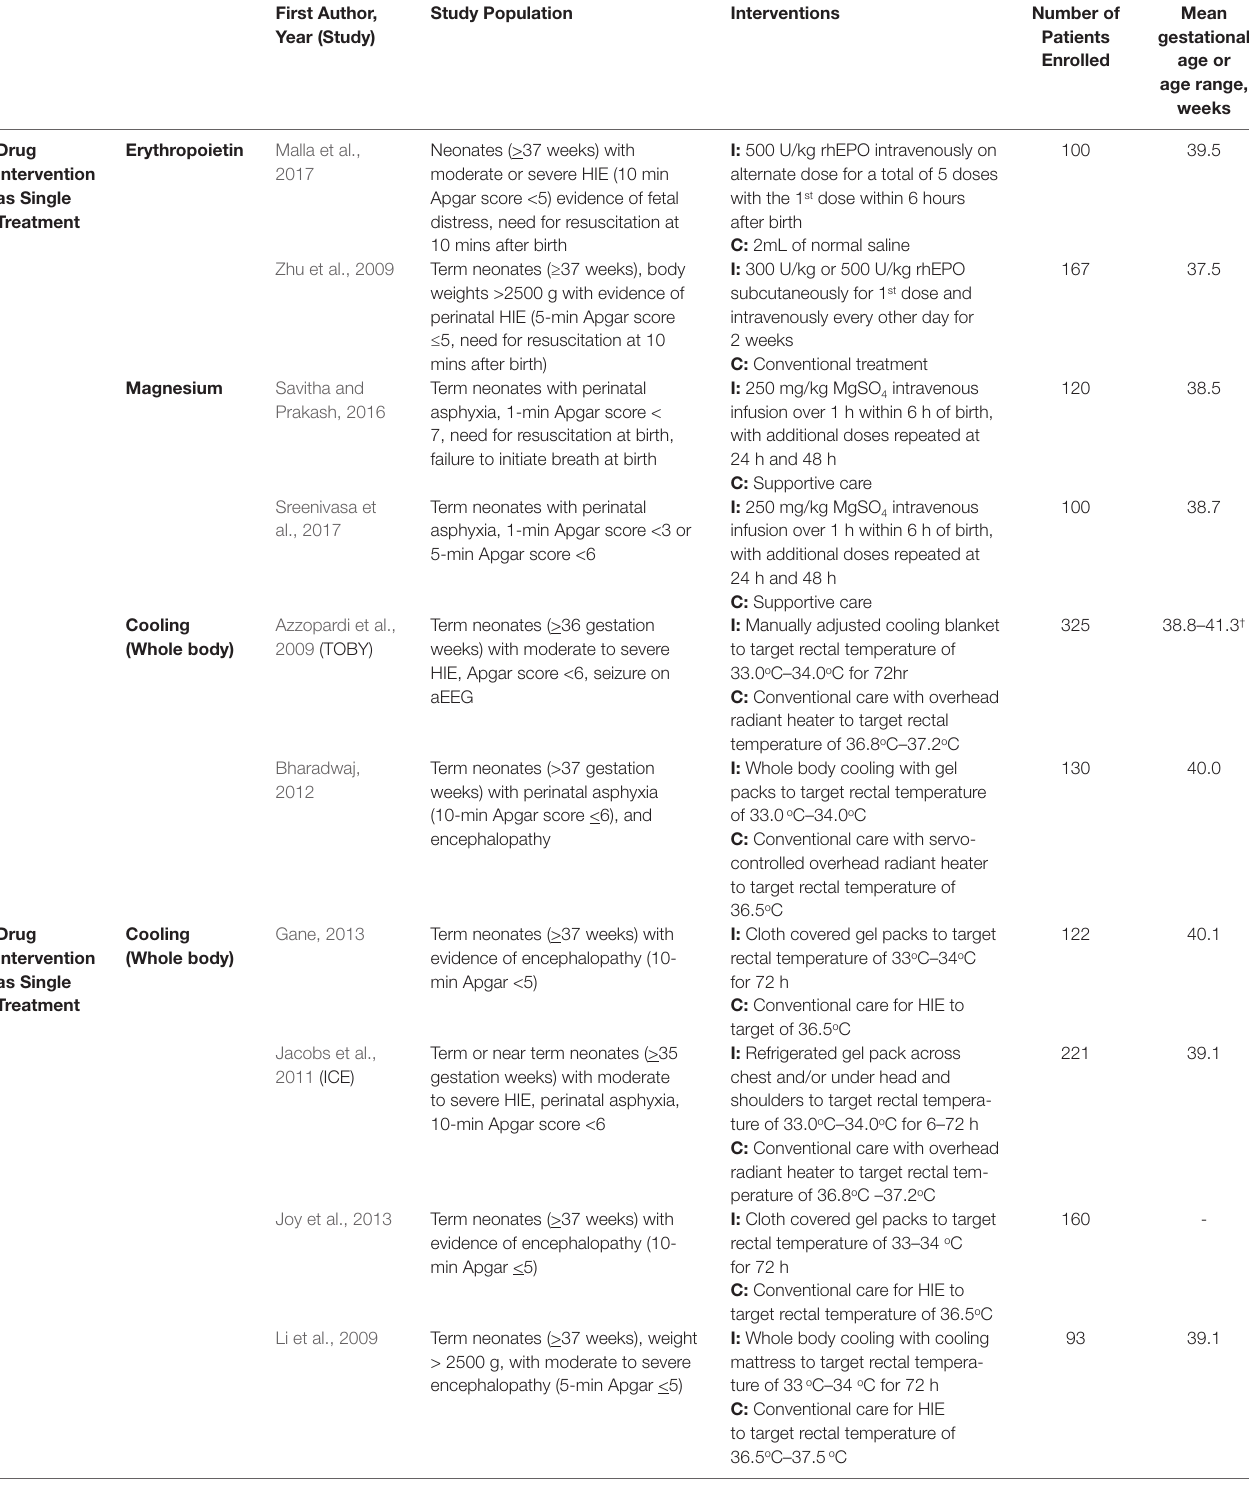
TABLE 1 | Characteristics of included